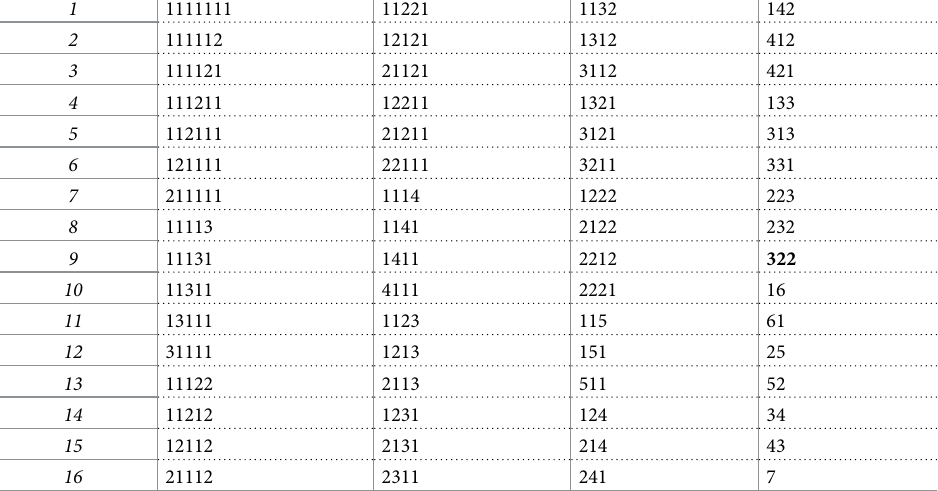
Table 3. Combinatorial